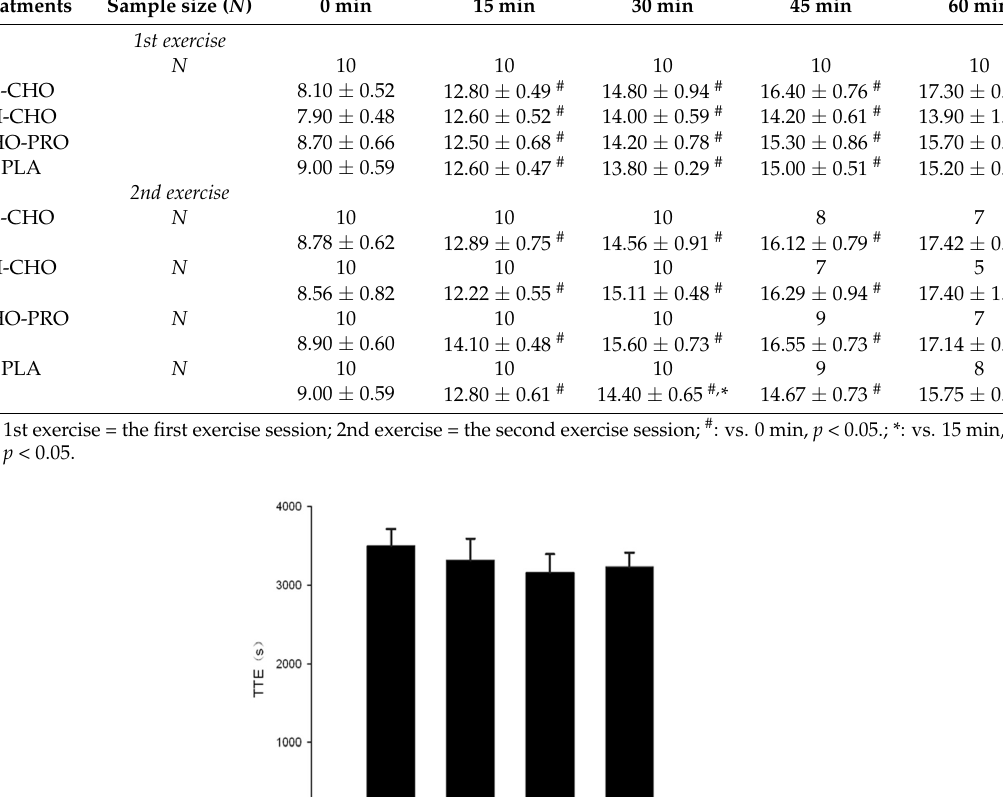
Figure 4. FAT oxidation rate in the first and second exercise sessions in study II ( # : vs. 0 min in the same exercise bout, p < 0.05; a: vs. 2nd exercise session in 60 min, p < 0.05). Table 5. Rating of perceived exertion following treatments.